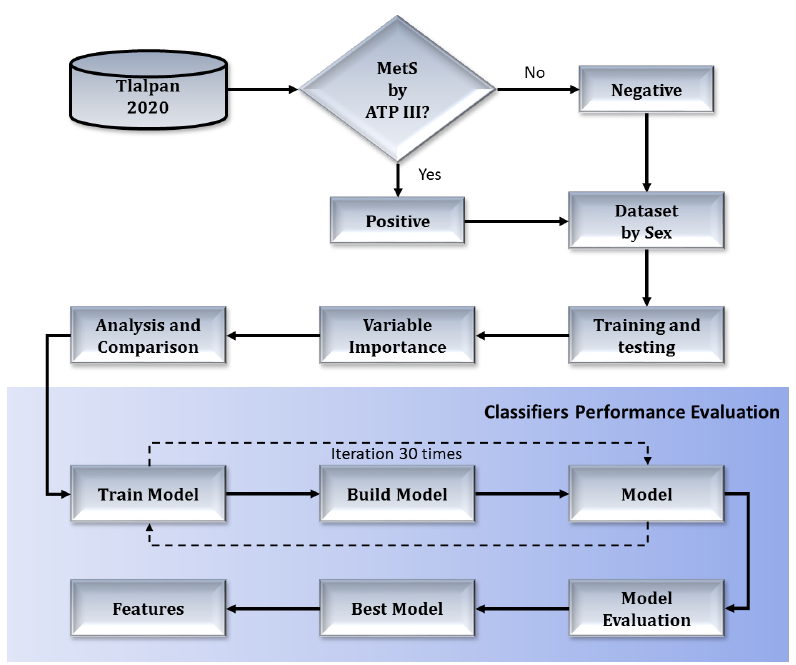
Figure 1. Prediction